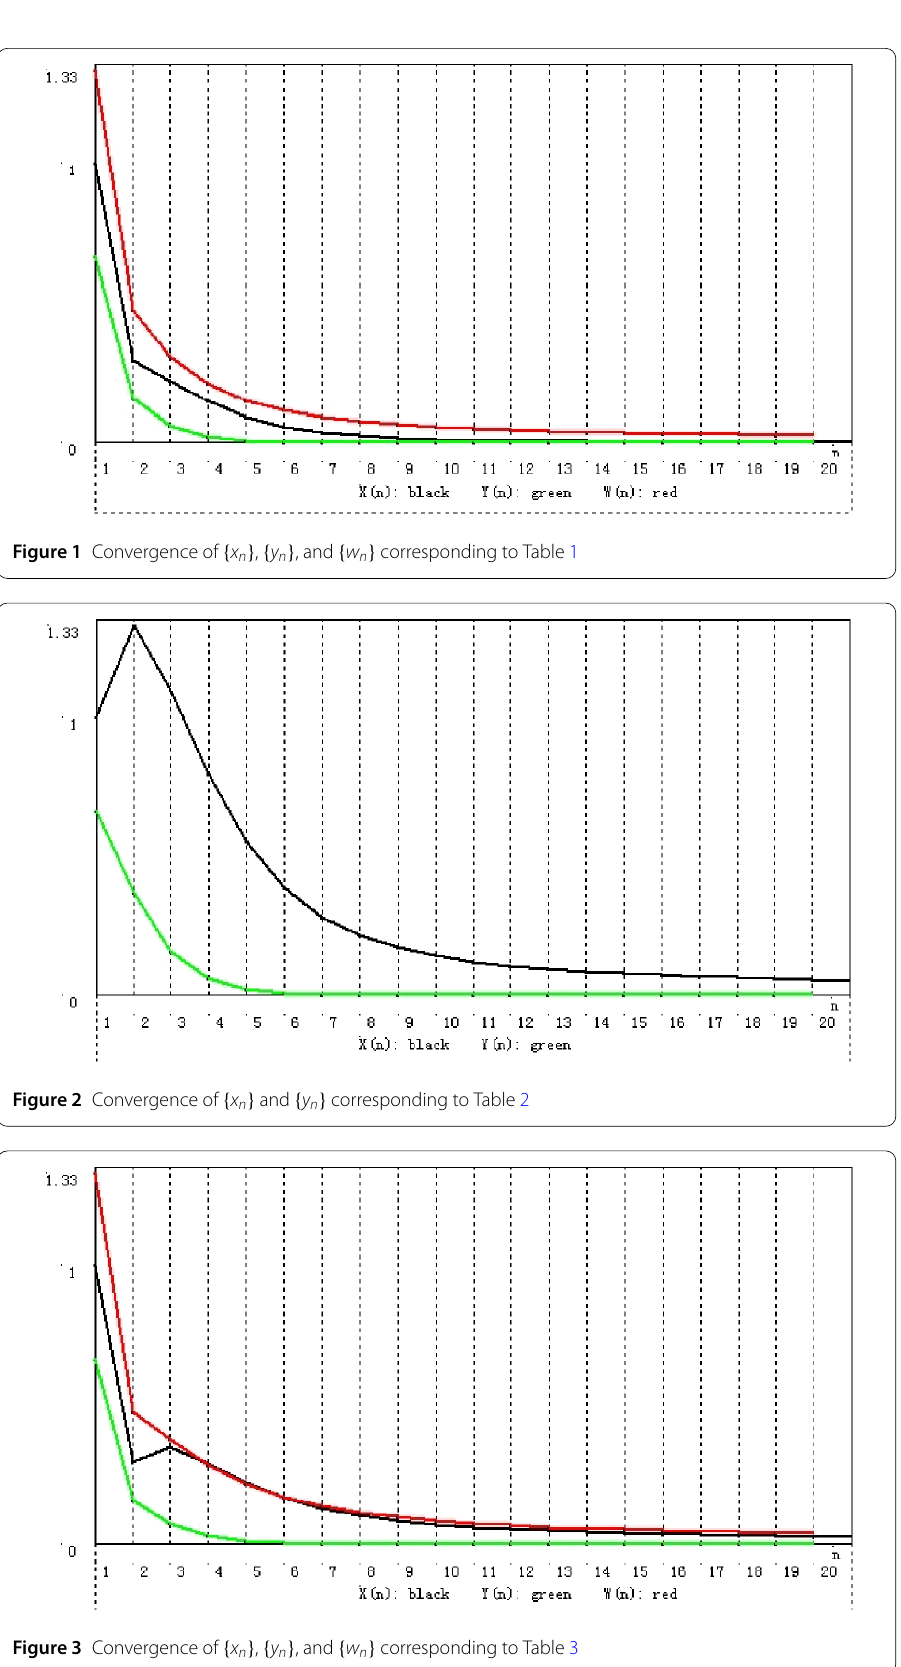
Figure 3 Convergence of { x n } , { y n } , and { w n } corresponding to Table